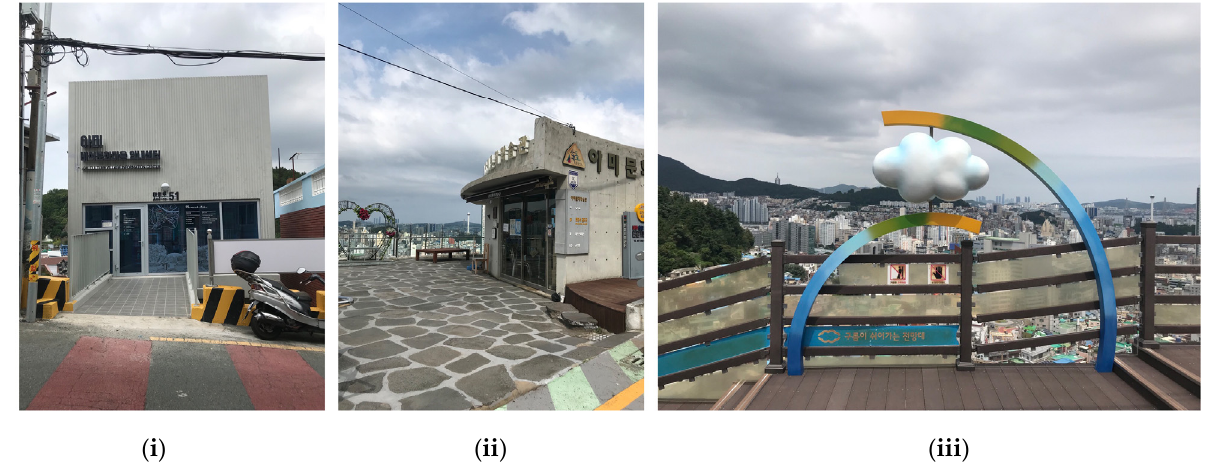
Figure 9. ( i ) Information Centre, ( ii ) Ami Cultural Learning Centre, ( iii ) Viewing Platform.